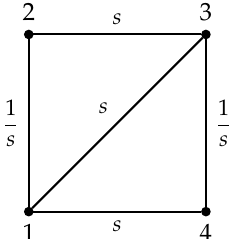
Figure 1. Graph, discussed in Example 1